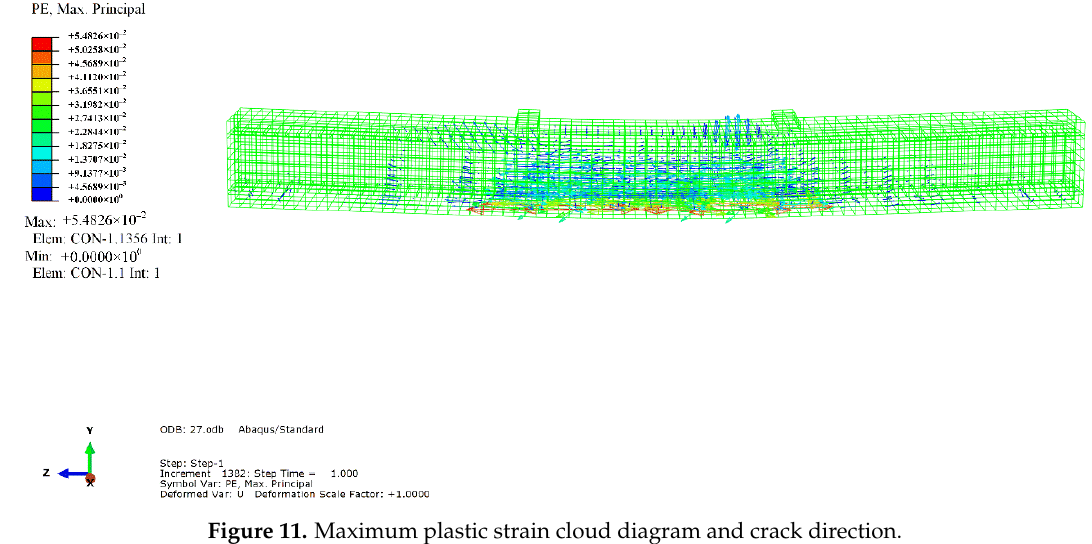
Figure 11. Maximum plastic strain cloud diagram and crack direction.